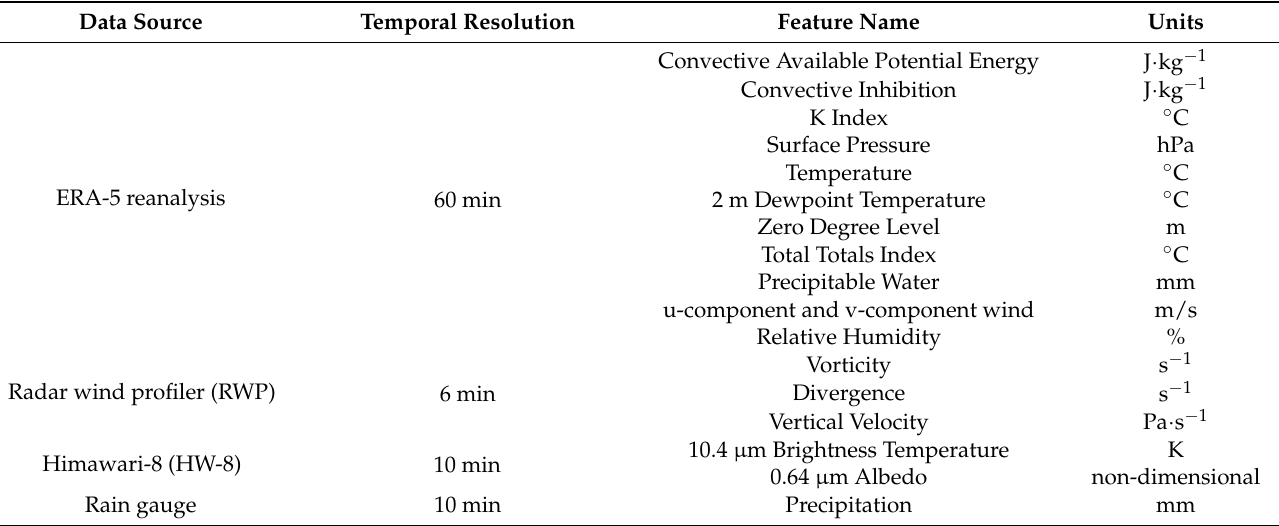
Table 1. The data sources of feature variables used as inputs for the RF